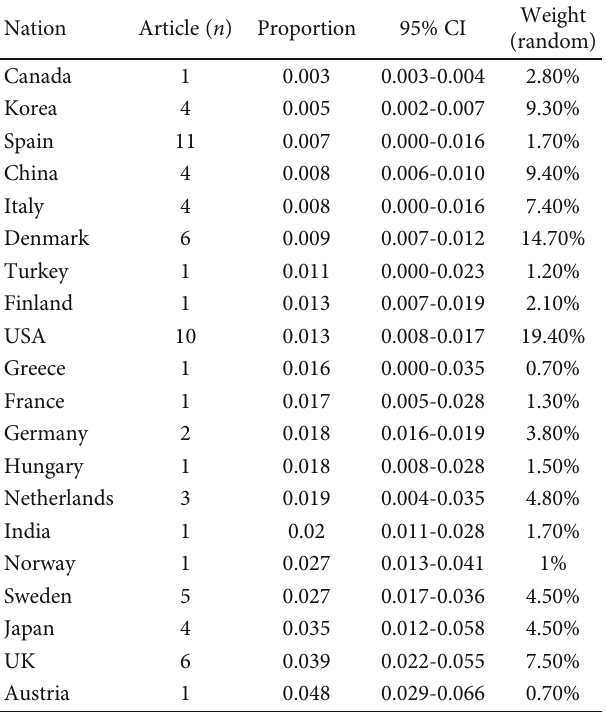
Table 7: CRC incidence in UC patients by country.